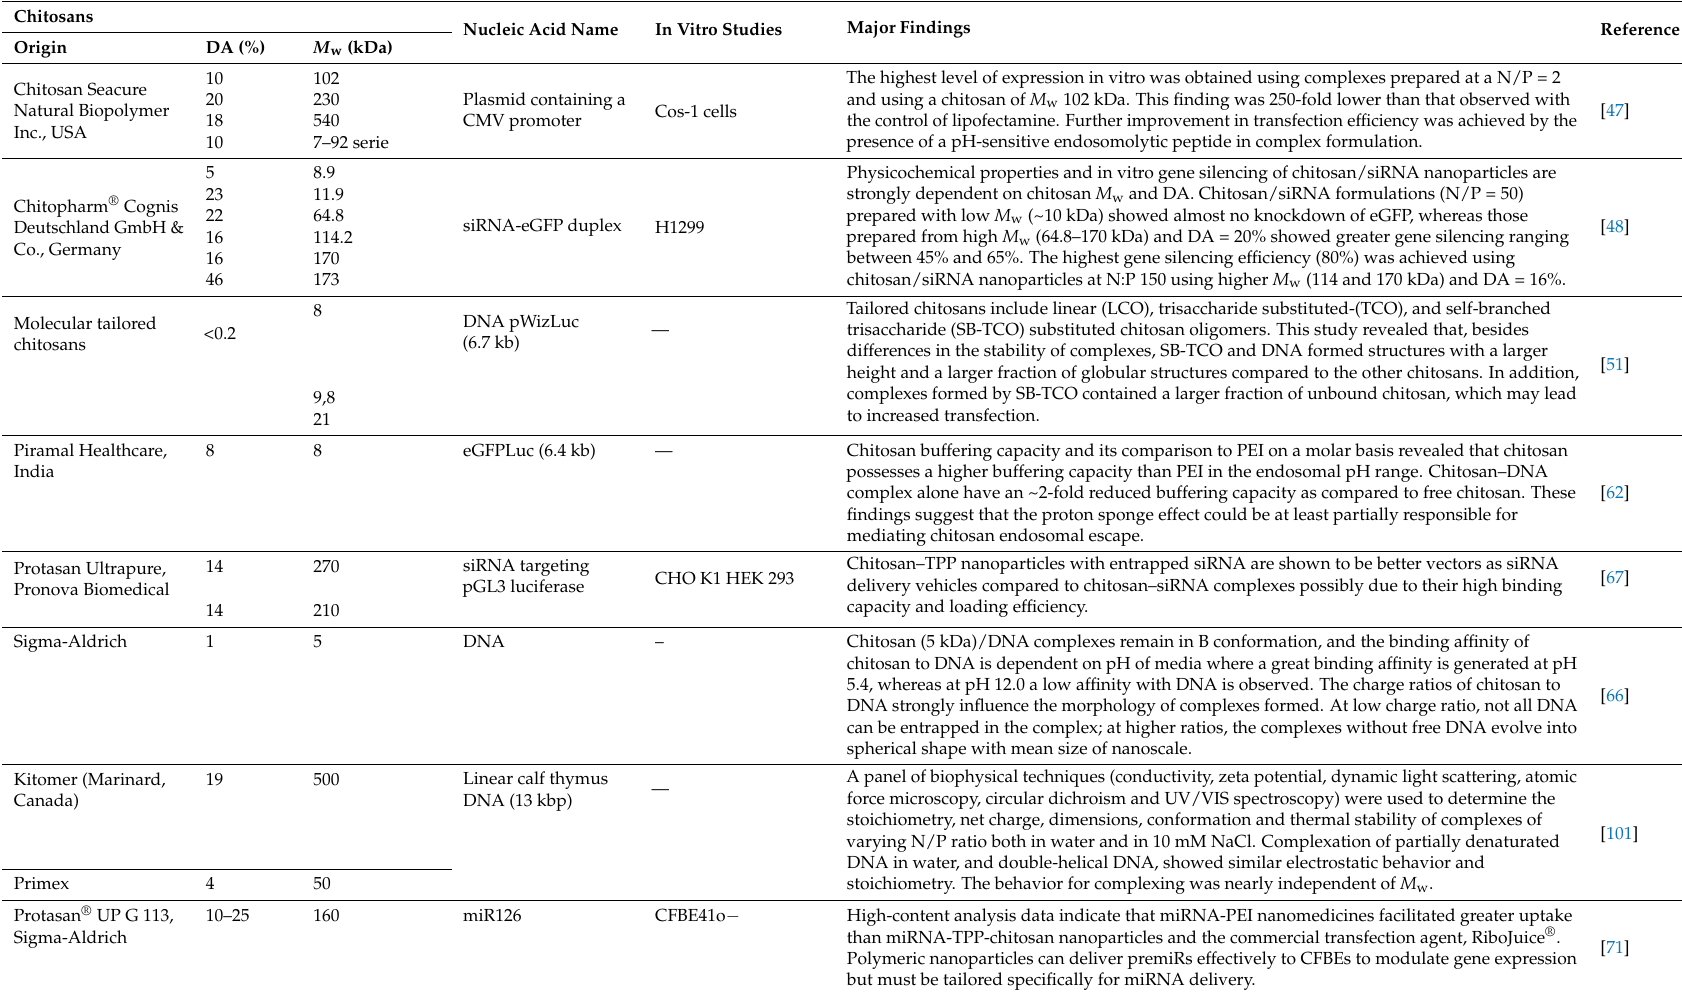
Table 1. Summary of chitosans used as non-viral delivery nanovehicles to associate different types of genes. Chitosans Nucleic Acid Name In Vitro